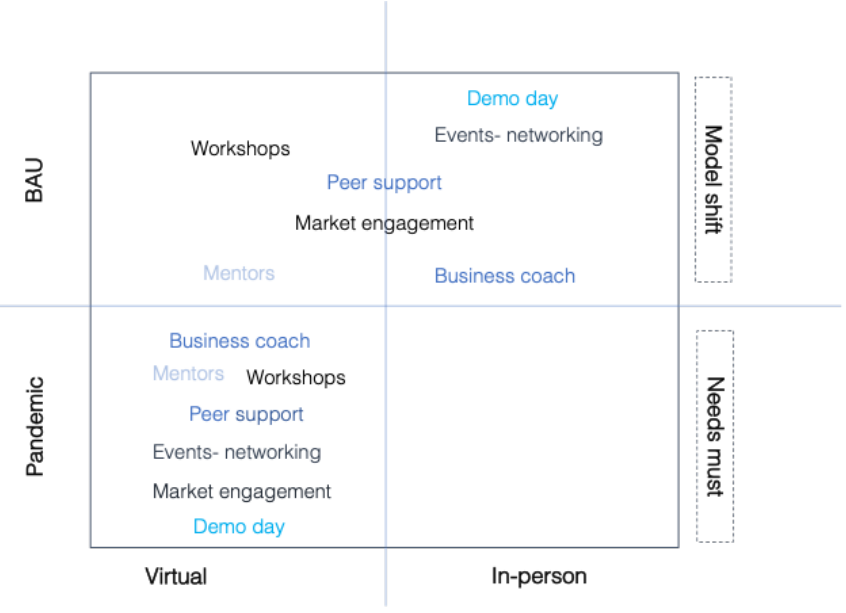
Figure 6. From Needs-Must to BAU Accelerator